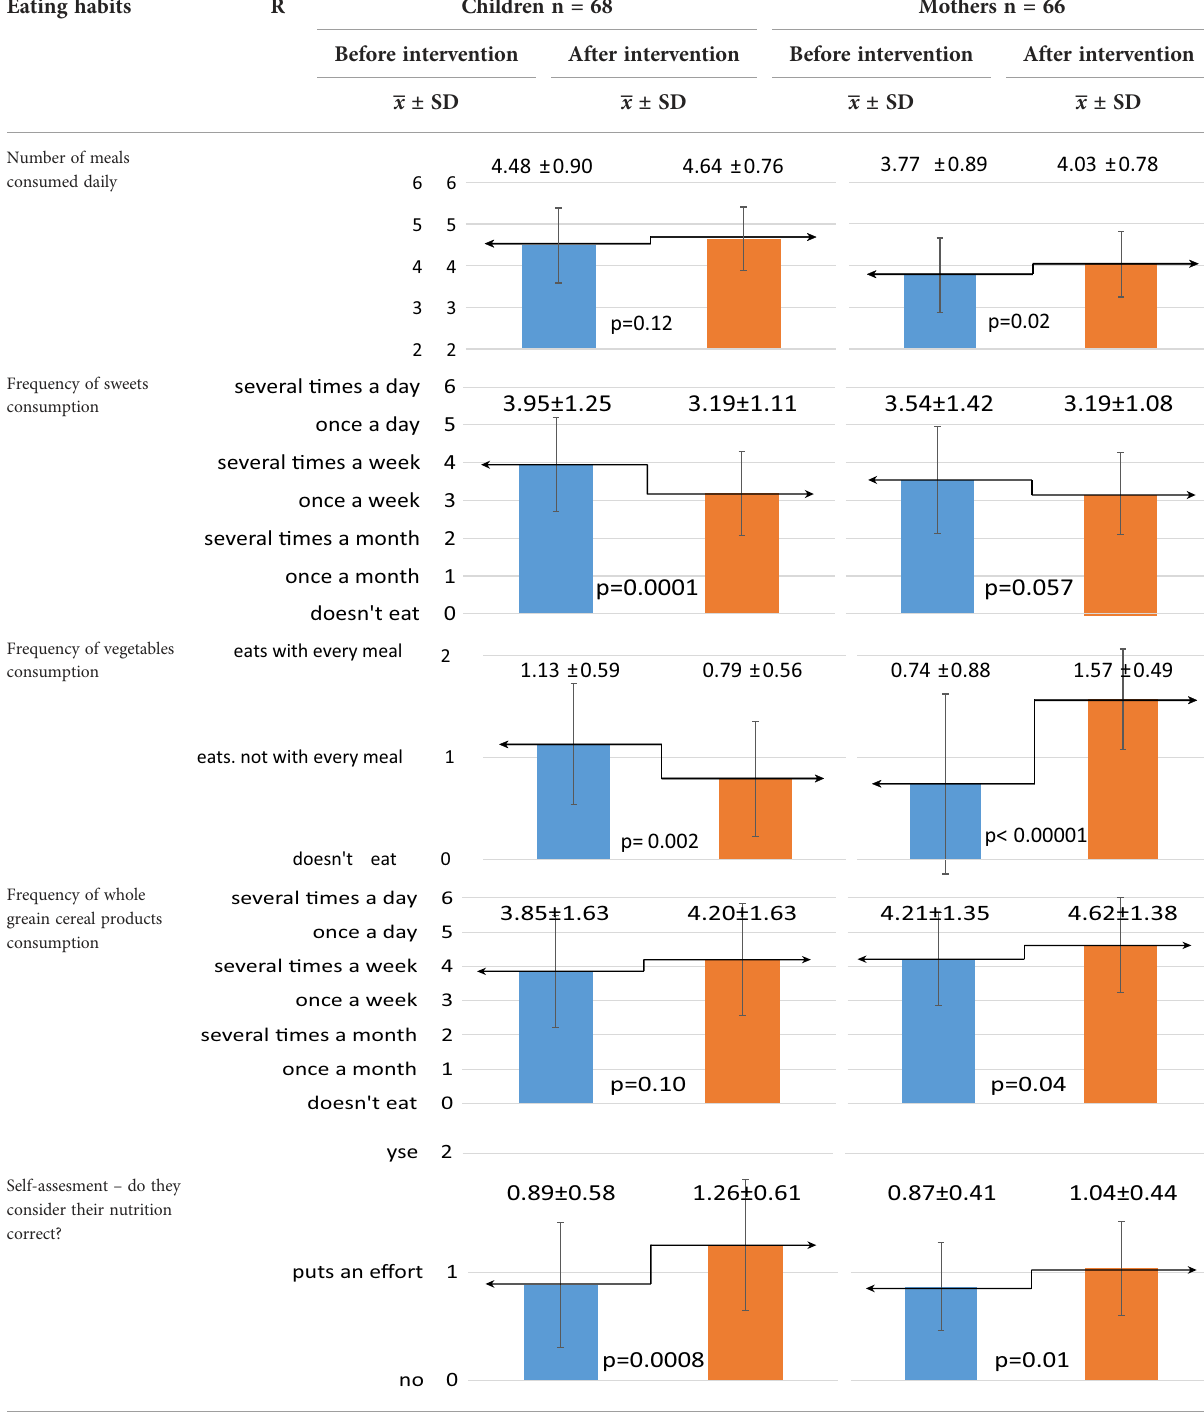
TABLE 3 Effect of dietary intervention on chosen eating habits in children and their mothers. Eating habits R Children n = 68 Mothers n = 66 Before intervention After intervention Before intervention After intervention x ̅ ± SD x ̅ ± SD x ̅ ± SD x ̅ ±